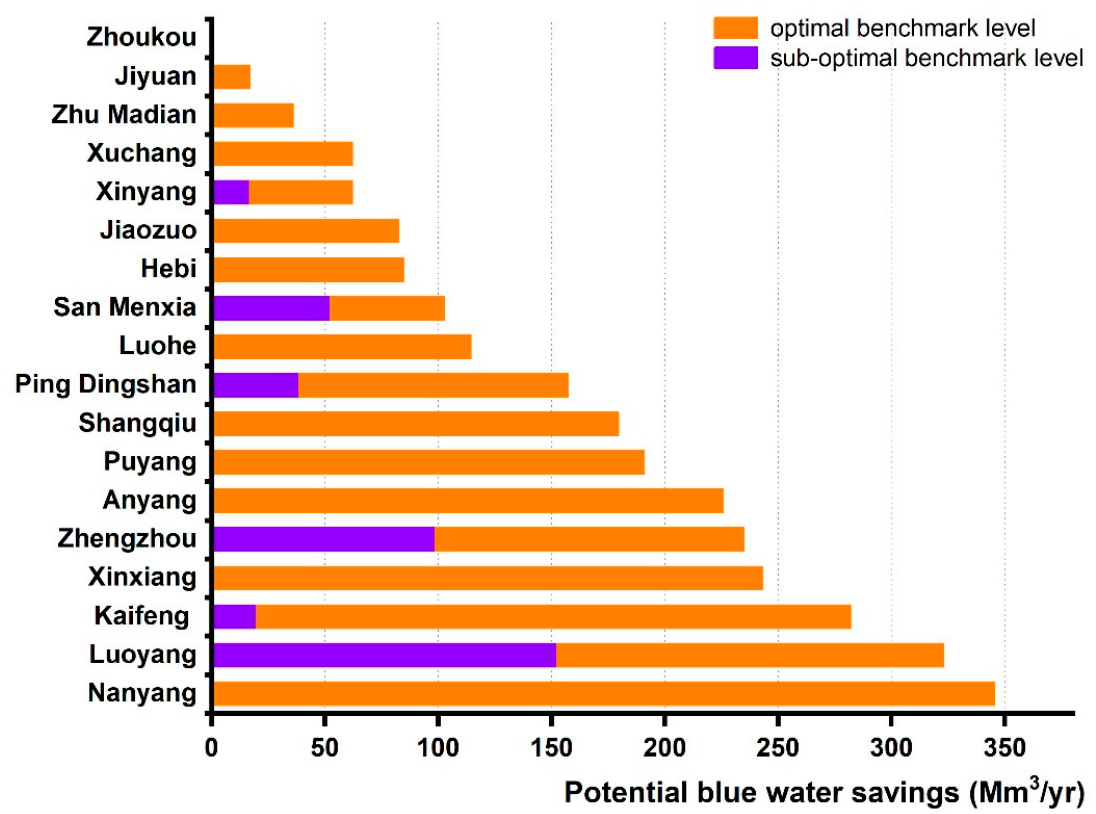
Figure 5. Potential blue water savings of wheat production at optimal or sub-optimal benchmark level in 18 cities.